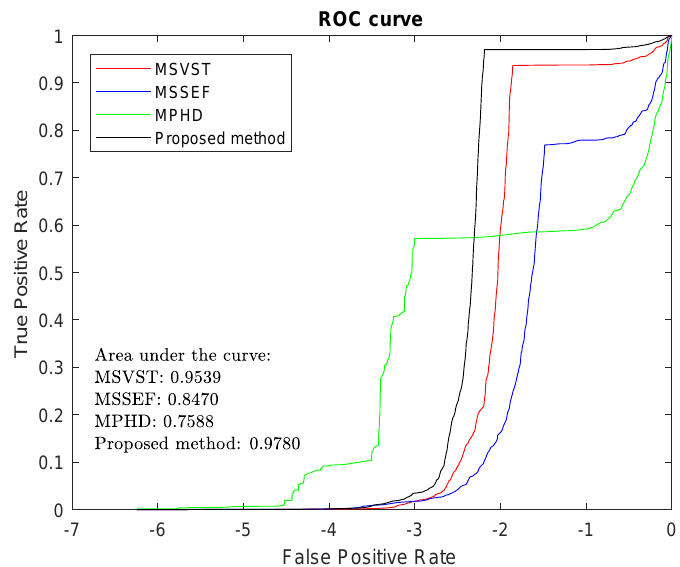
Figure 7. Comparison of the ROC curve obtained with MSVST, MPHD, MSSEF and the proposed methods.